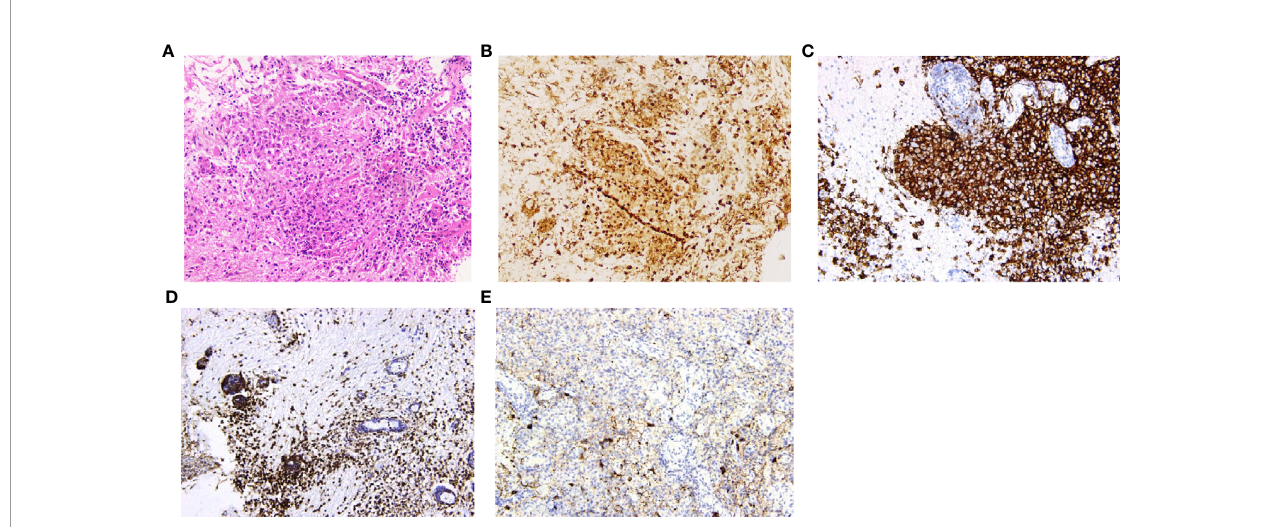
FIGURE 4 | Histopathology and immunohistochemistry manifestations of Langerhans cell histiocytosis (LCH) in patient No. 10. (A) H&E staining re fl ected marked histiocyte proliferation (H&E, ×200 original magni fi cation); Immunohistochemistry indicated clusters of various immunophenotypical markers [ (B) : CD68+, (C) : CD1a+, (D) : leukocyte common antigen (LCA)+, (E) : CD138+, ×200 original magni fi cation].